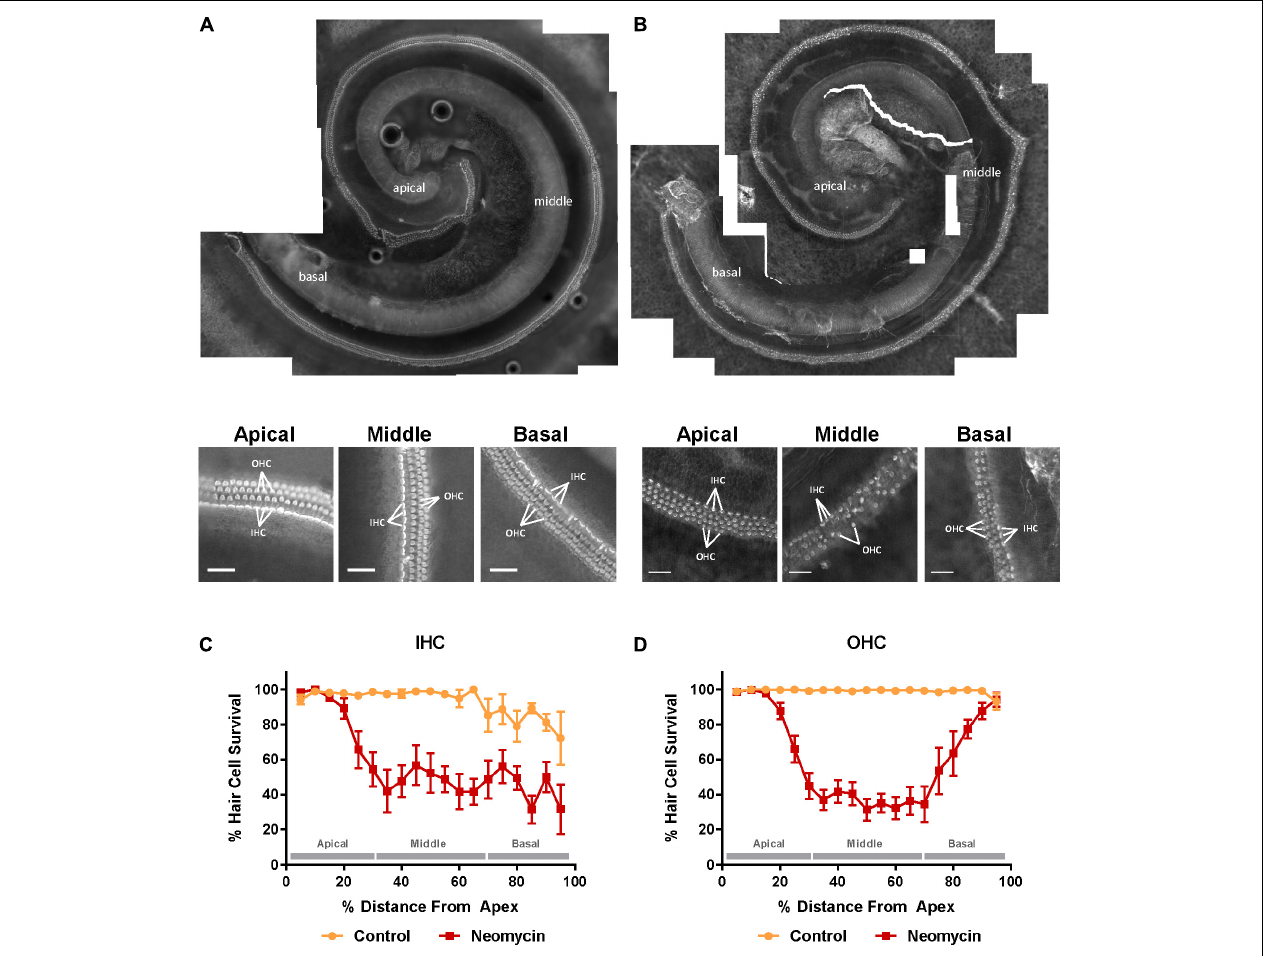
FIGURE 1 | Effect of neomycin on hair cell survival in the mouse P3 organ of Corti explant detected with Alexa Fluor 488-Phalloidin fluorescence imaging. (A) Intact cochlear explant incubated for 42 h in normal culture medium. Higher resolution images below show excellent preservation of sensory hair cells in the apical, middle, and basal segment. (B) The P3 mouse organ of Corti explant exposed to neomycin (1 mM) for 3 h in the middle of the 42 h timeframe. Inner and outer hair cell (IHC, OHC) preservation was generally very good in the apical region of the cochlea, with a gradient to reduced preservation in the middle segment and poor among IHC with some loss of OHC in the basal segment. Scale bar = 30 µ m . (C) IHC were equally susceptible to neomycin toxicity in the middle and the basal segment of the cochlea resulting in an L-shaped cochleogram. (D) In contrast, OHC were most susceptible to neomycin in the middle segment of the cochlea resulting in a U-shaped cochleogram. Data presented as mean ± SEM. Control explants, n = 7; explants exposed to neomycin, n =